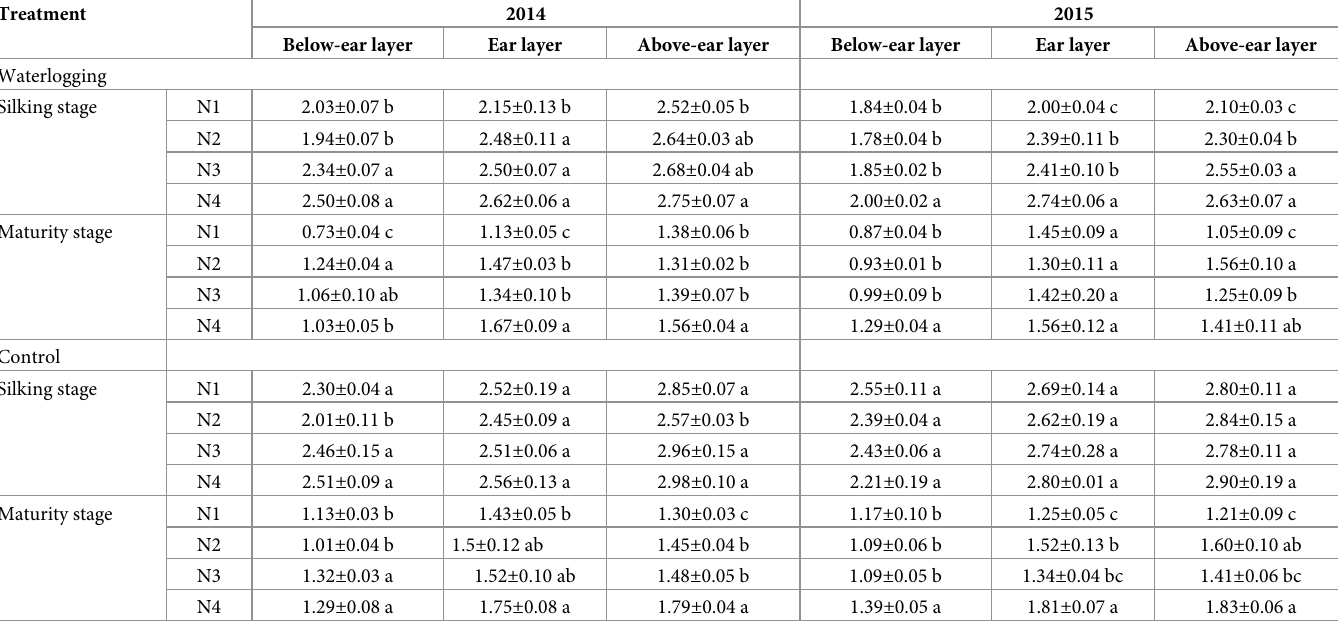
Table 1. Leaf N concentrations in different leaf layers at the silking and maturity